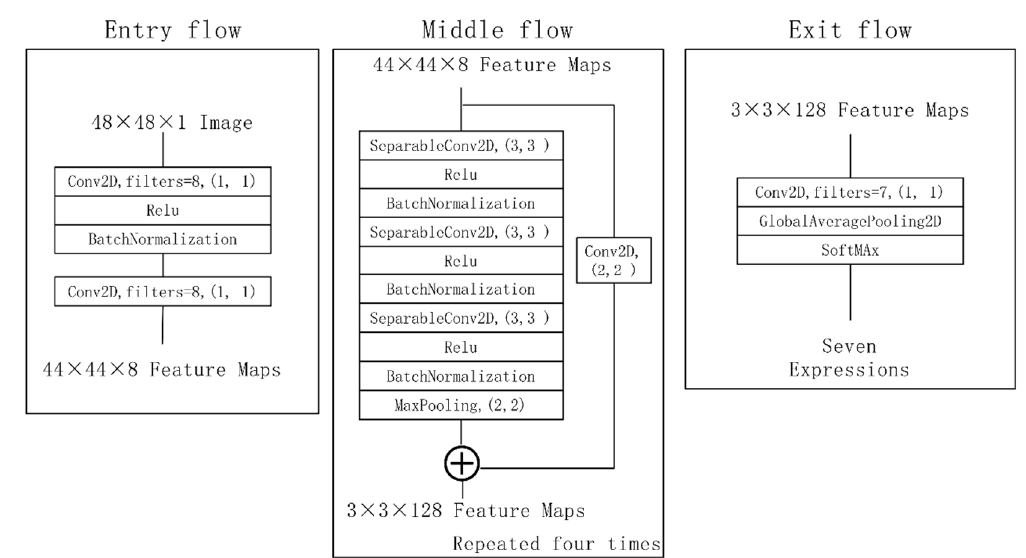
Figure 10. RM-Xception network structure parameters diagram.